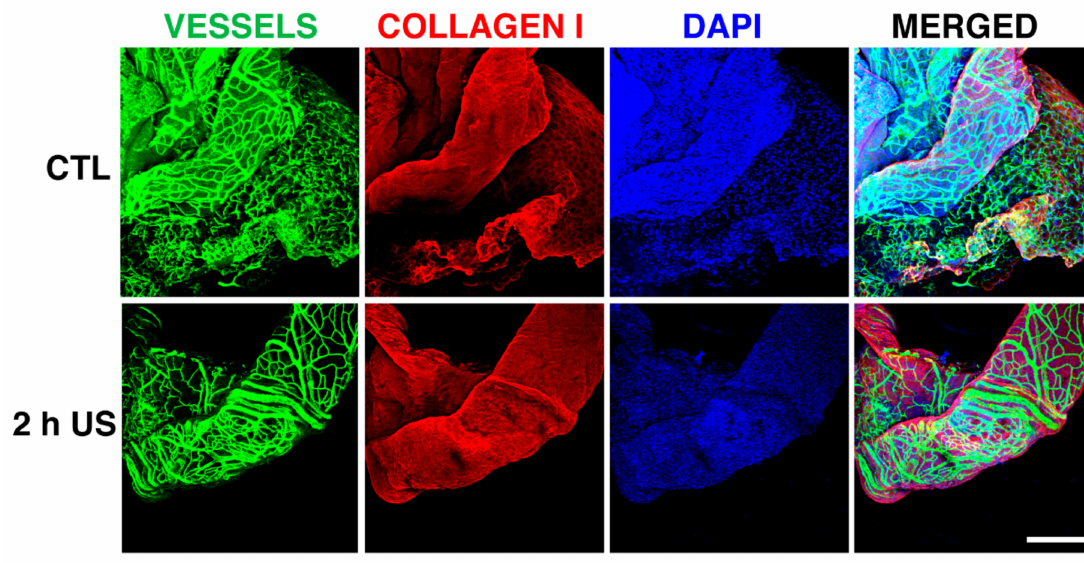
Figure 3. Confocal immunofluorescence images of mouse pancreatic tumor explants. Application of LICU for 2 h had no detectable effect on tumor vasculature (green) and collagen I (red) deposition. Cell nuclei were stained with DAPI (blue). Scale bar is 250 µ